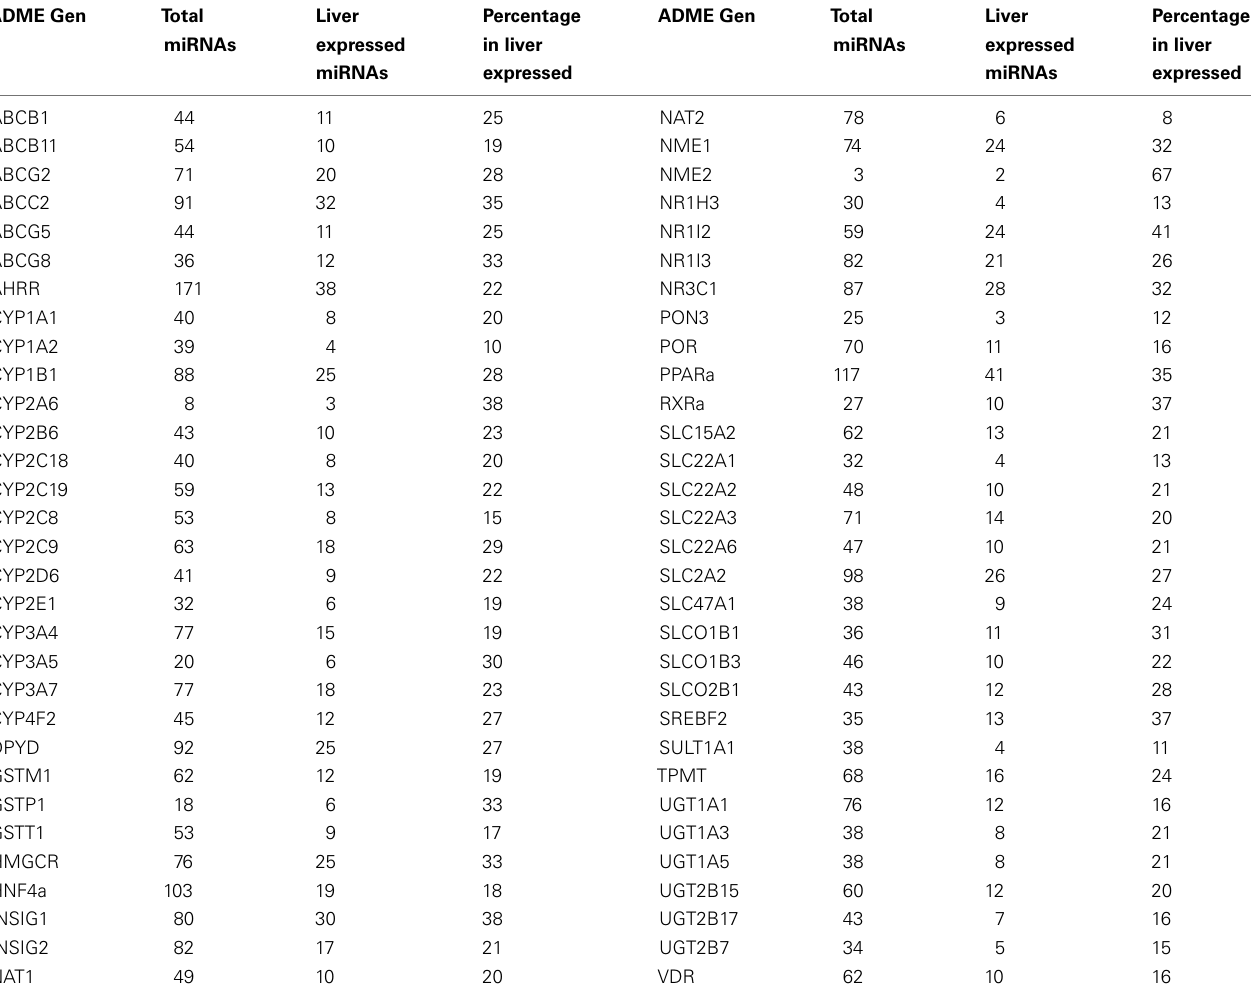
Table 1 | Illustration of predicted miRNA binding sites with and without specific filter options. ADME